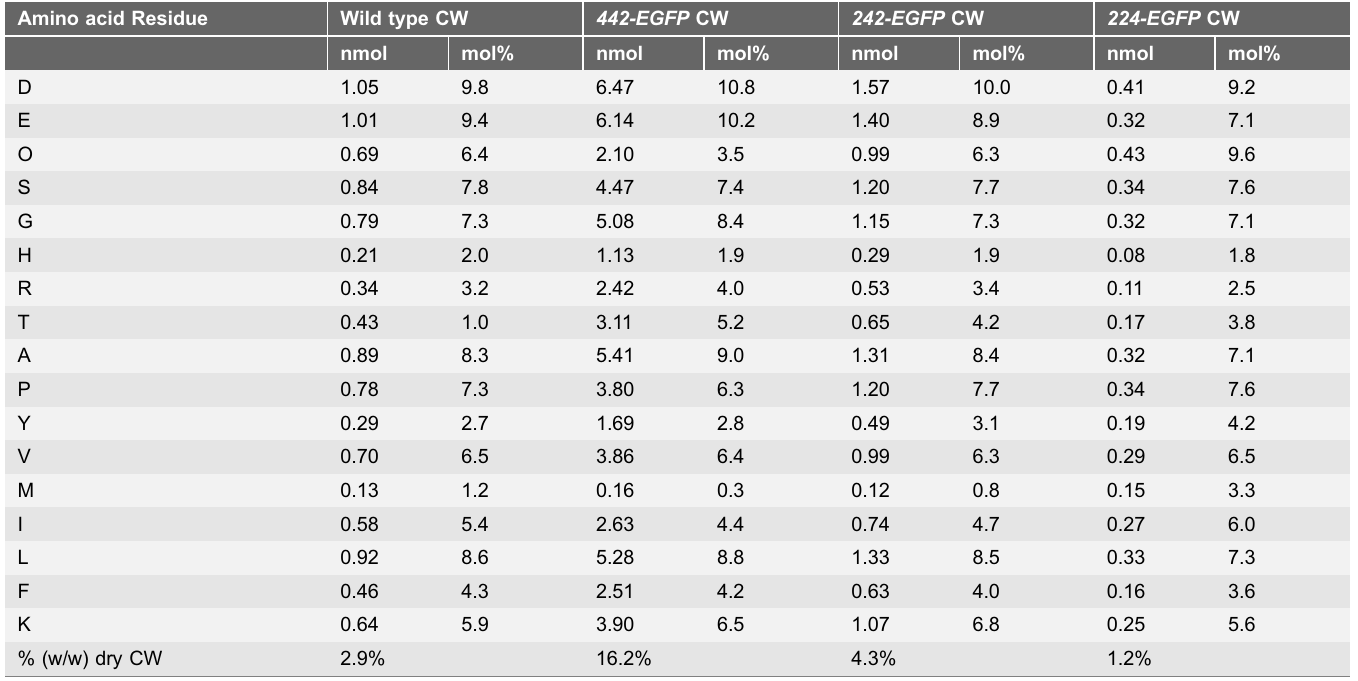
motifs of 442-EGFP might allow more efficient cross-linking than 224-EGFP and 242-EGFP which each contain only two P3 extensin motifs in tandem (Fig. 1). These results are consistent with our speculation that a small portion of the 442- EGFP fusion glycoproteins that saturated the walls might have been cross-linked via the di-IDT cross-linking amino acids. To further check the chemical basis of wall property changes, we analyzed the glycosyl residue compositions of the transgenic cell walls. Analyses of neutral sugars hydrolyzed with 2 N TFA and uronic acid residues hydrolyzed with SO showed that the 442-EGFP cell walls contained similar concentrated H 2 4 amount of total monosaccharides as wild type (Table 6). Given the protein Table 5. Amino acid composition of each cell wall (CW)